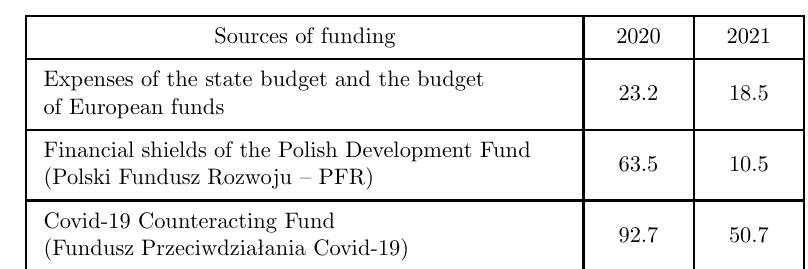
Value of government aid programs related to countering the